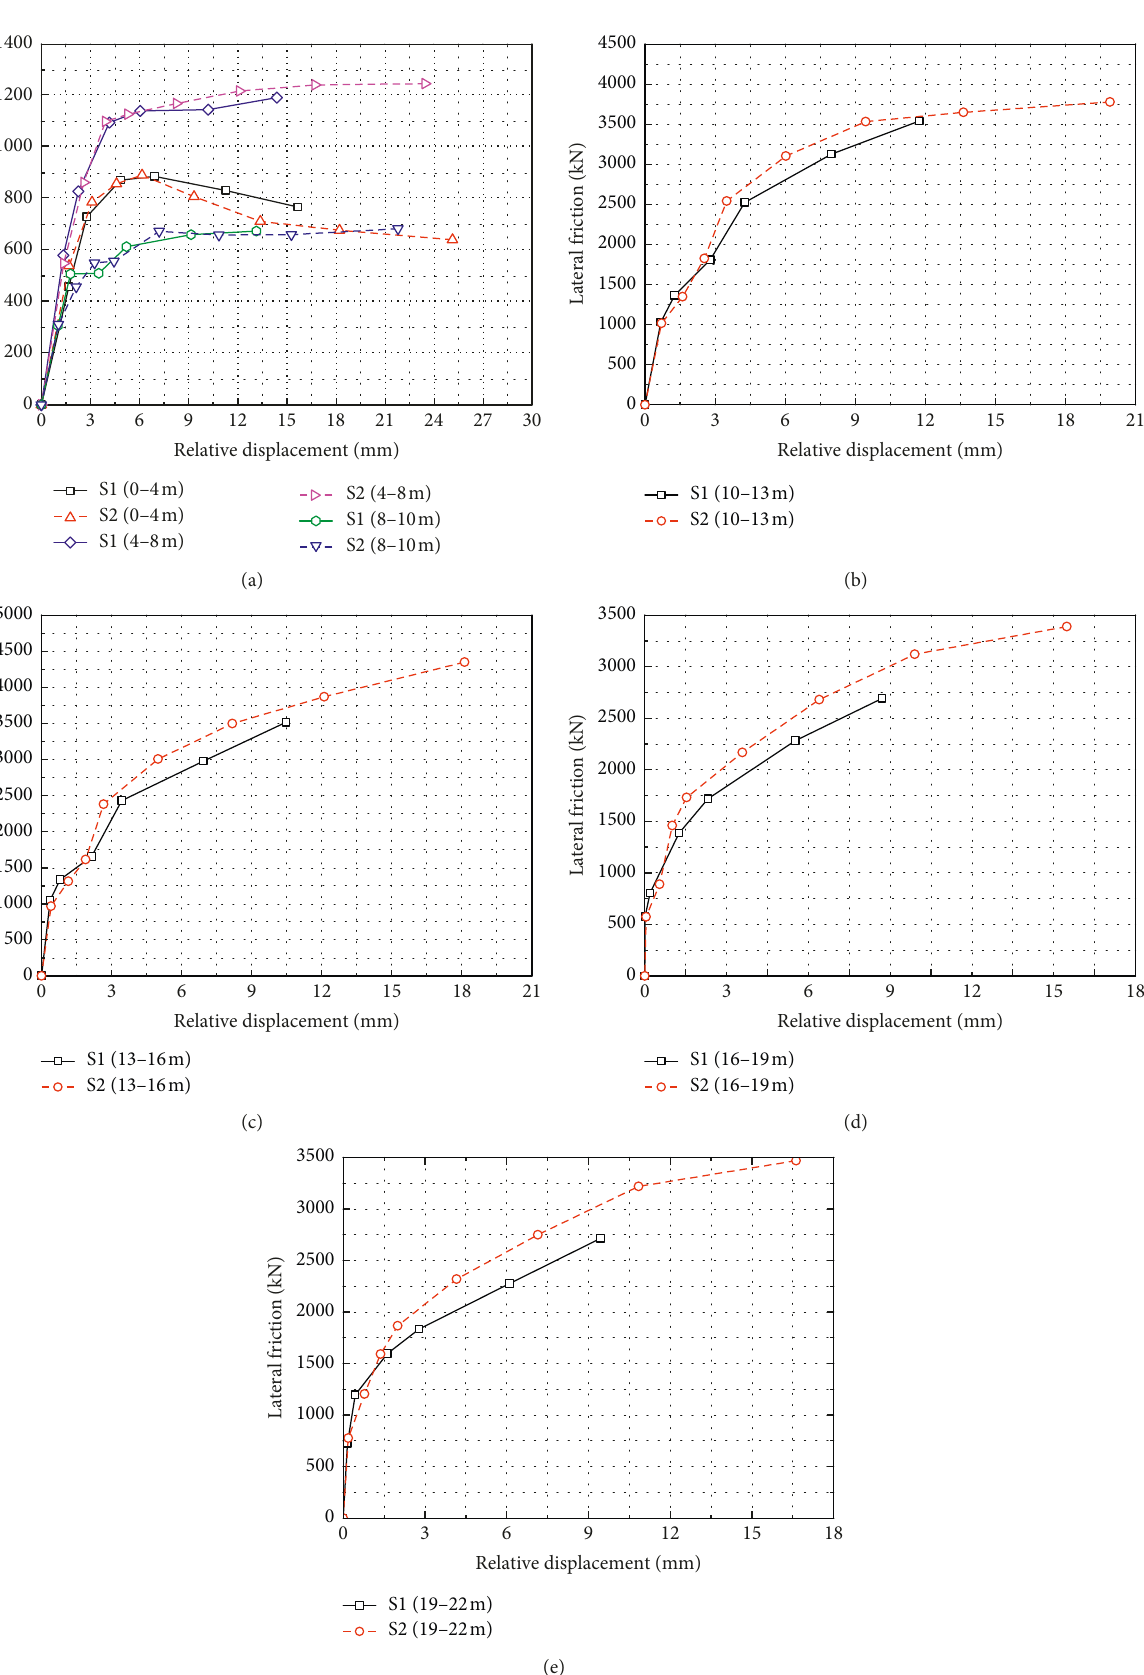
Figure 5: Relative displacement curve: part of (a) 1–10m, (b) 10–13m, (c) 13–16 m, (d) 16–19 m, and (e) 19–22